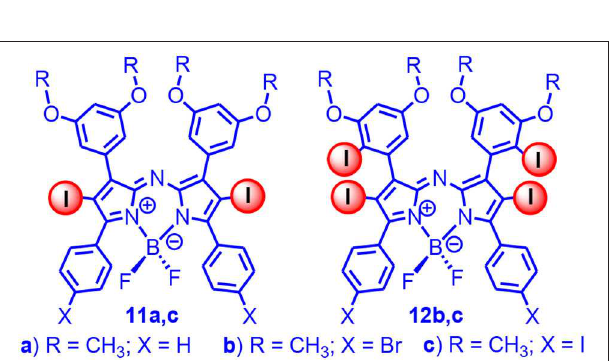
FIGURE 3 | Di- and tetraiodoAzaBodipy showing absorption at